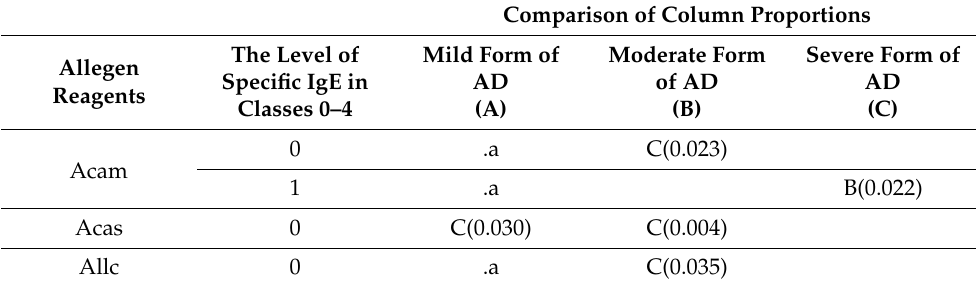
Table 5. The detailed comparison of sensitization to allergen reagents (allergen extracts and molecular component) according to the level of specific IgE (Classes 0, 1, 2, 3, 4) in patients suffering from mild, moderate, and severe form. We show only the significant relation ( p -value <